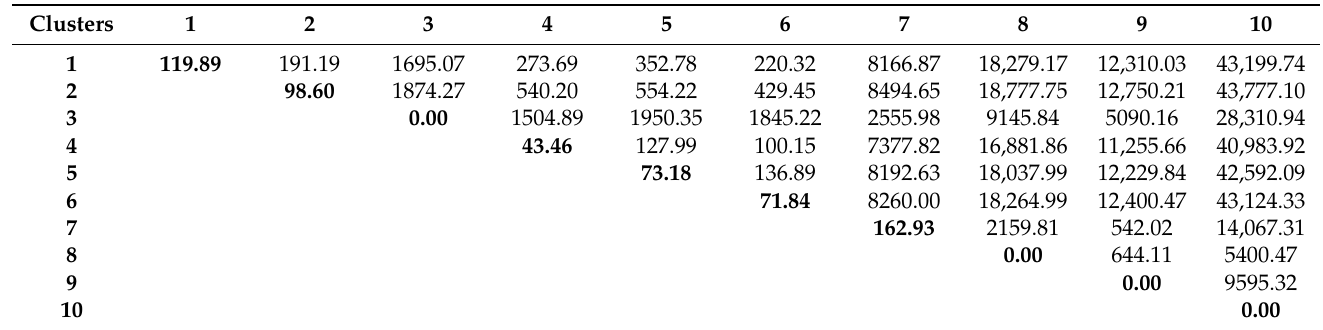
Table 4. Intra-(diagonal) and inter-(off diagonal) cluster distance values of 81 carrot genotypes grown under potential environment of